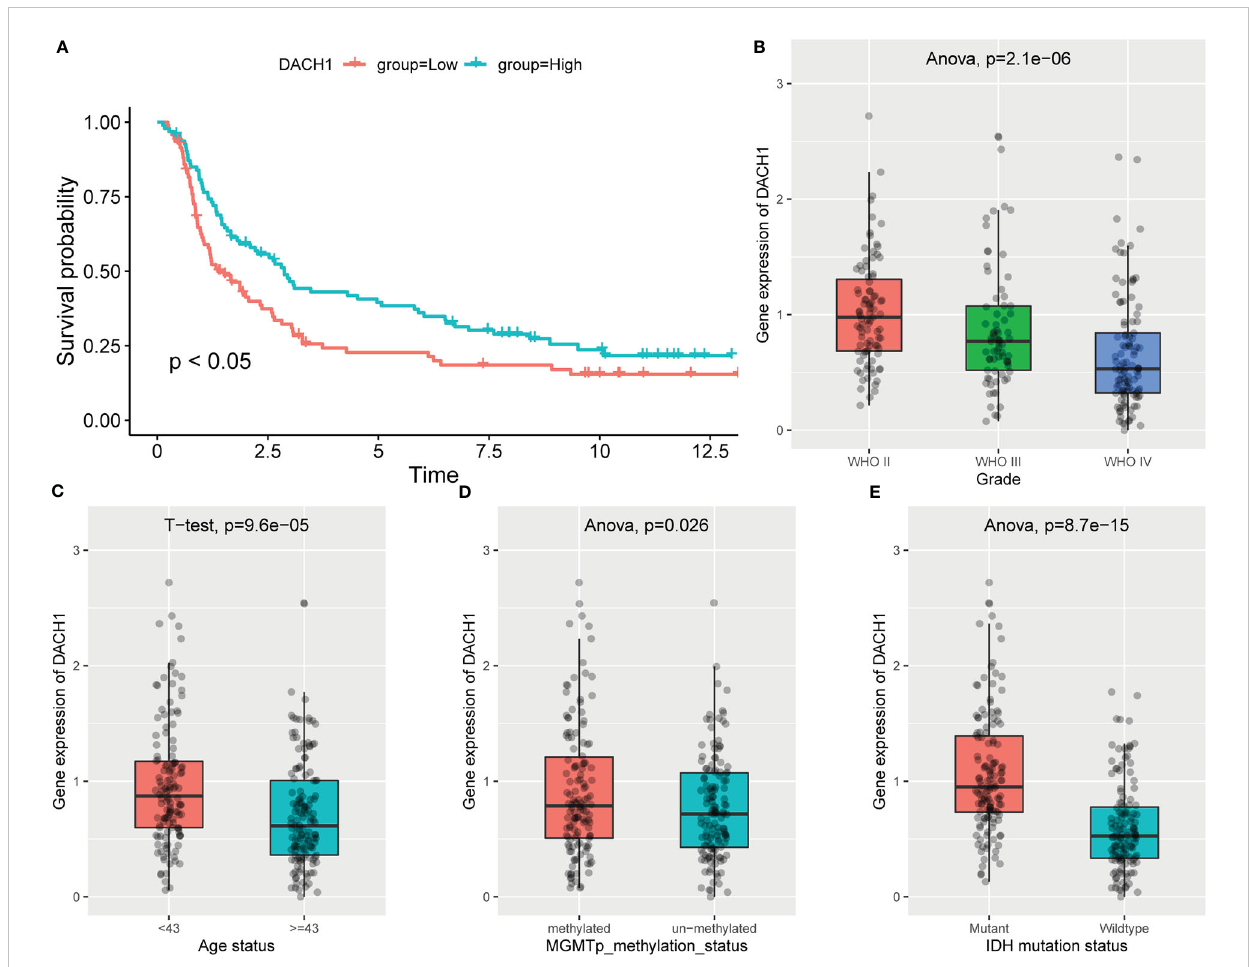
FIGURE 12 The relationship between the expression of DACH1 and clinical features. (A) Red indicates the DACH1 low expression group, and green indicates the DACH1 high expression group. Patients with low expression had a lower survival rate than those with high expression (P < 0.05). (B) The expression of DACH1 decreases with increasing glioma grade. (C) The expression of DACH1 in the >=43-year-old group was signi fi cantly lower than that in the <43-year-old group (P < 0.05). (D) The expression of DACH1 in the non-methylated group was signi fi cantly lower than that in the methylated group (P < 0.05). (E) The expression of DACH1 in the IDH wild-type group was signi fi cantly lower than that in the IDH mutant group (P <